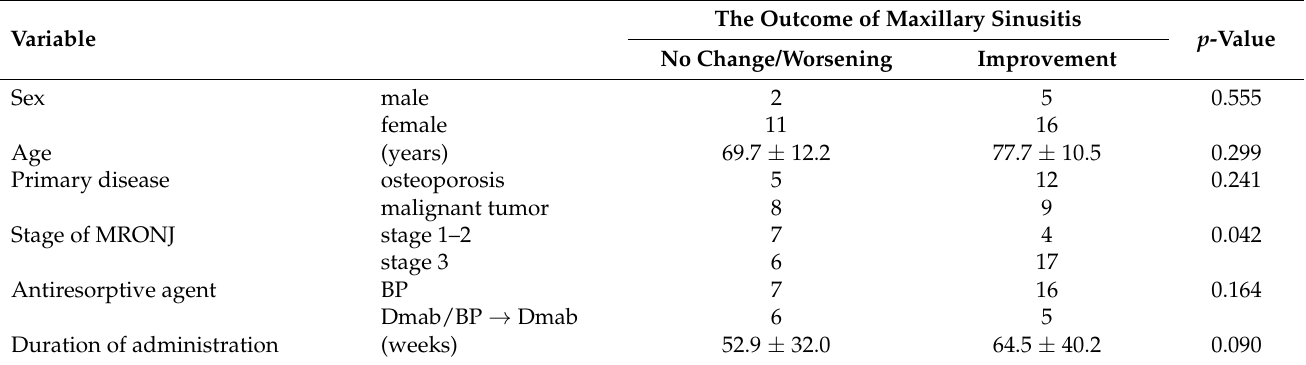
Figure 6. Three cases of maxillary sinusitis healing by intraoperative irrigation. Table 3. Factors related to treatment outcome of maxillary sinusitis (univariate